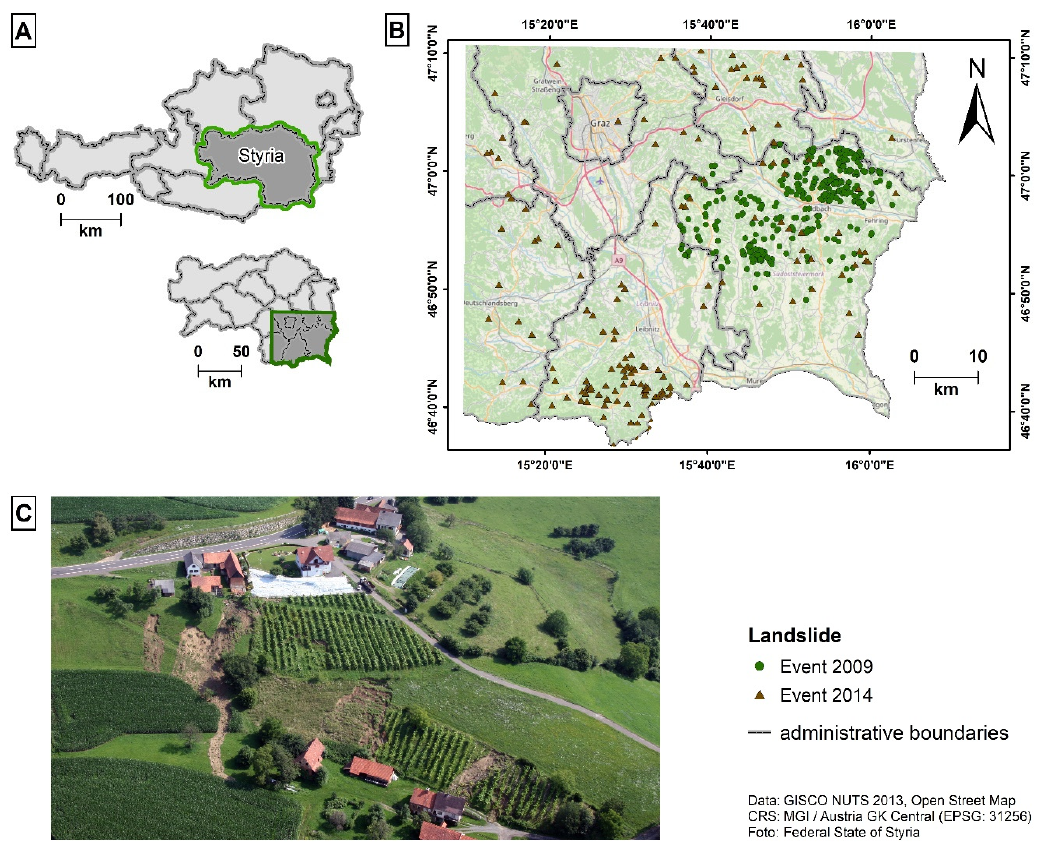
Figure 1. Overview of the study area and rainfall-induced landslides: ( A ) Location in the federal state of Styria (lower part) and Austria (upper part); ( B ) Study area with landslide occurrences during extreme rainfall events; ( C ) Examples of shallow landslides in 2009.